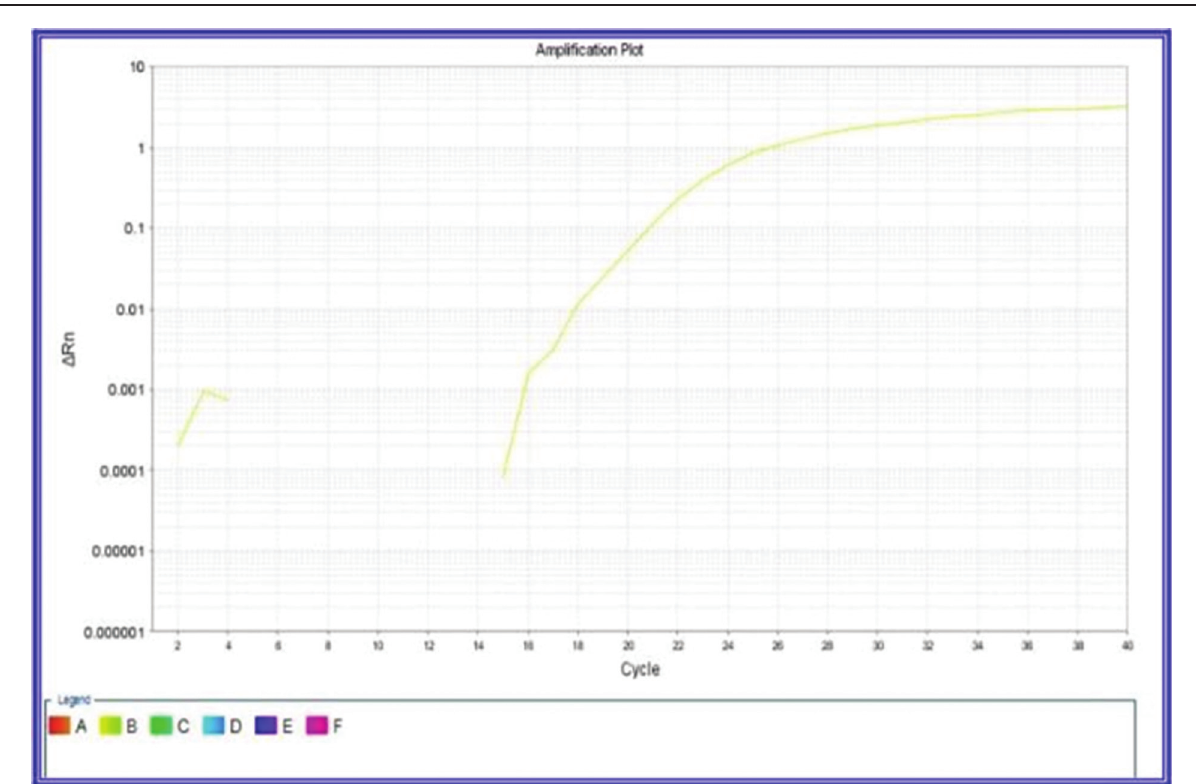
Positive Mycoplasma pneumoniae control curve.